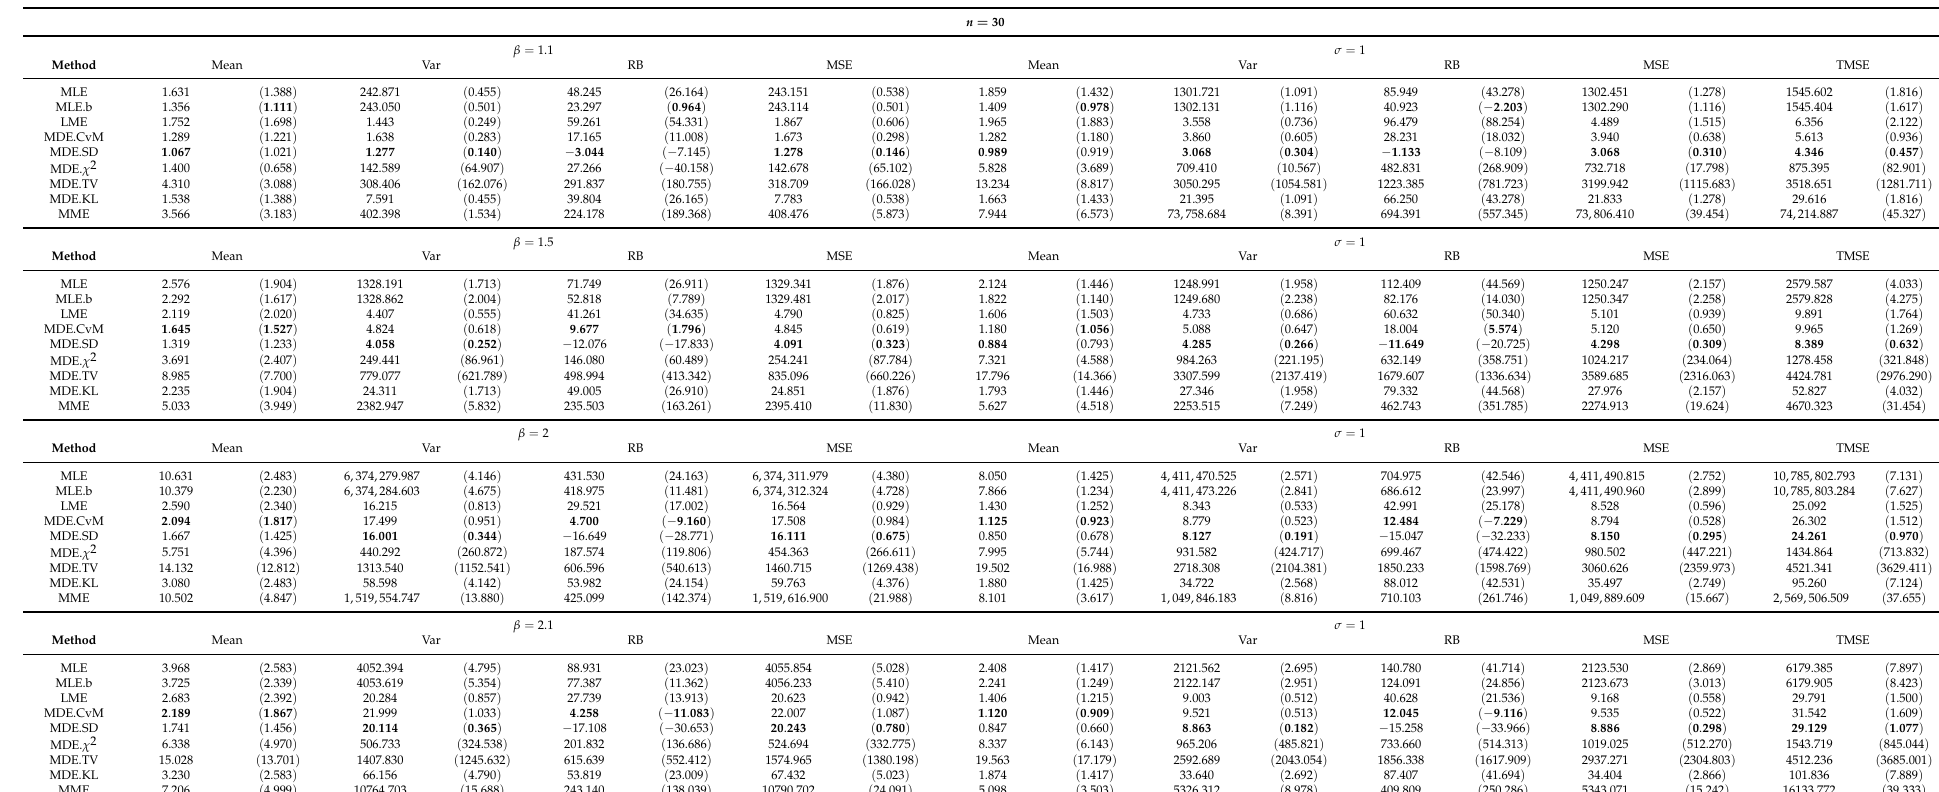
Table 1. Comparison of different estimation methods for different values of β ( σ = 1 and n =